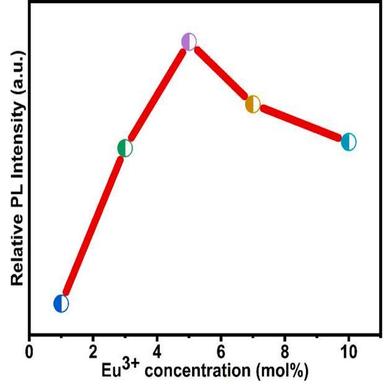
Interdependence of the PL intensity and composition of the Eu3+ doped Ba2La4Zn2O10 (1.0–10.0 mol%) nanophosphor.